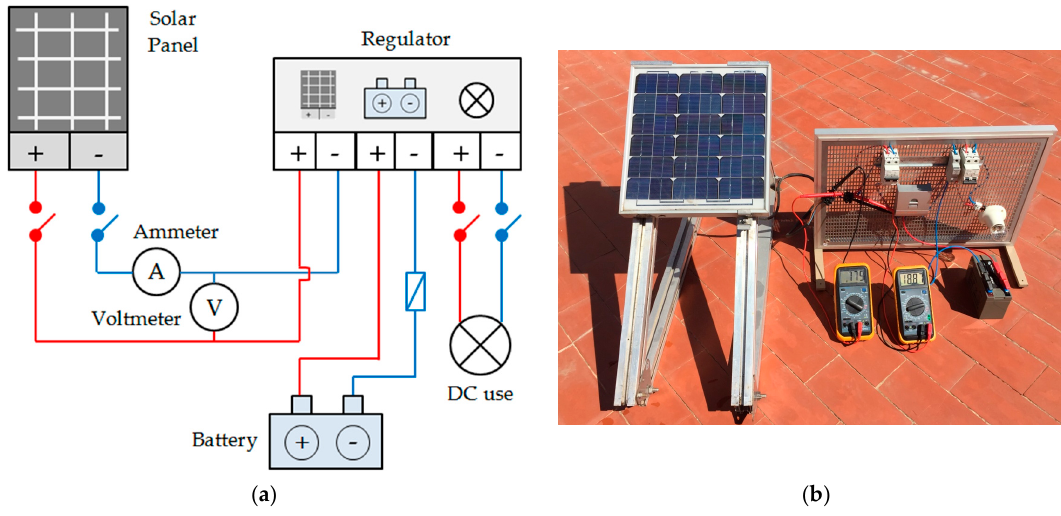
Figure 10. ( a ) Connection scheme of static installation; and ( b ) applied installation.